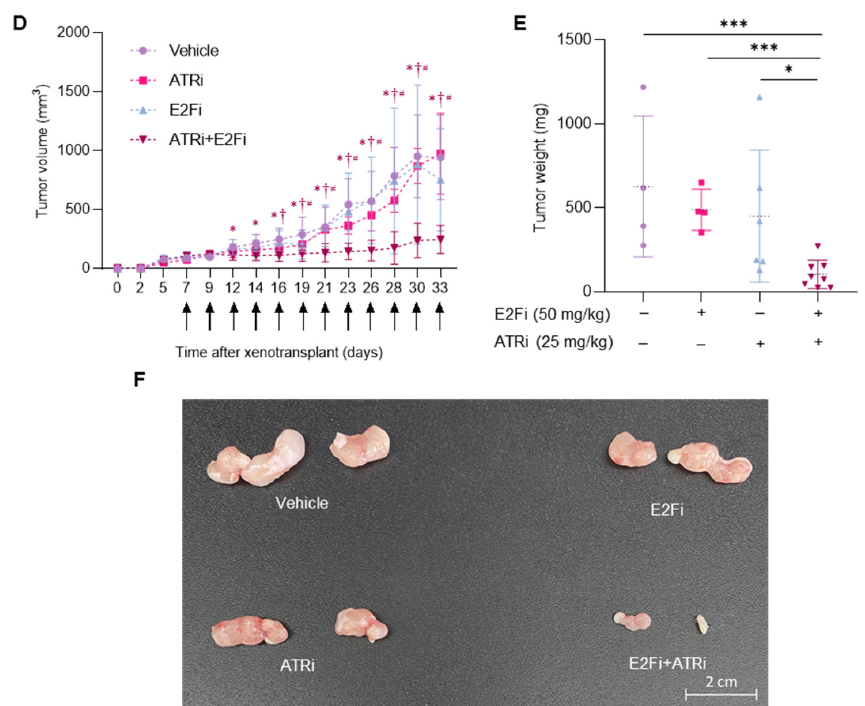
Figure 7. Combination of E2Fi and ATRi enhances genomic instability and reduces cell growth in PC3 cells in vitro and in xenografts. ( A ) Intensity of γ H2AX signal in cells in S phase 24 h after the indicated treatments. Data of 500 cells from one representative experiment of 3 independent experiments are shown. Data are expressed as Log10 intensity. Horizontal bars mark mean intensity. Statistical analysis was performed using ANOVA and Fisher’s test. *** p < 0.0001. ( B ) Intensity of γ H2AX signal in cells in S phase 24 h after the indicated treatments. Data of 300 cells from one representative experiment of 3 independent experiments are shown. Data are expressed as Log10 intensity. Horizontal bars mark mean intensity. Statistical analysis was performed using ANOVA and Fisher’s test. *** p < 0.0001. ( C ) Representative images of colony density in each condition. PC3 cells were treated with E2Fi (5 µ M) and ATRi (0.1 µ M) alone or in combination. 24 h later, drugs were washed out and cells were incubated with fresh media for an additional 10–12-day period. Then, cells were fixed and stained with crystal violet. Graph shows the quantification of CFA. Crystal violet was dissolved with acetic acid and the absorbance was measured by spectrophotometry. Relative cell viability was calculated by normalizing the absorbance of each condition using their vehicle controls. Statistical analysis was performed using ANOVA and Fisher’s test. *** p < 0.0001, ** p < 0.001, * p < 0.05. ( D ) PC3 xenograft growth after treatment with E2Fi and ATRi. PC3 cells were injected subcutaneously into both flanks in 20 CD-1 nude mice. When tumor volume reached 65 mm 3 , mice were divided in 4 groups (Vehicle, E2Fi, ATRi and combination). E2Fi and ATRi were administered IP at 50 mg/kg and 25 mg/kg, respectively. Growth curves depict mean ( ± SD) of the tumor volume. Arrows indicate the days of injection. n = 4–8 tumors per group. Statistical analysis was performed using ANOVA and Fisher’s test. * p < 0.05 vs. vehicle, † p < 0.05 vs. E2Fi, # p < 0.05 vs. ATRi. ( E ) Weight of the tumors obtained at the endpoint from mice treated as indicated. n = 4–8. Statistical analysis was performed using ANOVA and Fisher’s test. *** p < 0.0001, * p < 0.05. ( F ) Representative tumors from control and experimental mice are